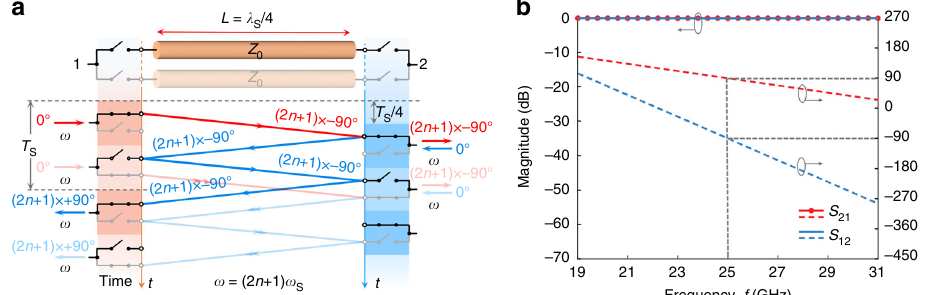
Fig. 1 Non-reciprocal phase shifter based on a delay line with switches. a Schematic and operation diagram of the non-reciprocal phase shifter, consisting of a transmission line of characteristic impedance Z 0 (which is the same as the port impedance) and delay T s /4, sandwiched between ideal switches clocked at ω s with 50% duty cycle and quarter-period delay between them. This structure provides a non-reciprocal phase shift of − (2 n + 1) π /2 and − 3(2 n + 1) π /2 for ω = (2 n + 1) ω s , where n = 0, 1, 2, 3, … , corresponding to the case of a gyrator. b Scattering parameters for the case with two complementary branches and f s = 8.33 GHz. The return losses at both ports are zero for all frequencies. At 25 GHz ( n = 1), ideal lossless gyrator behavior is